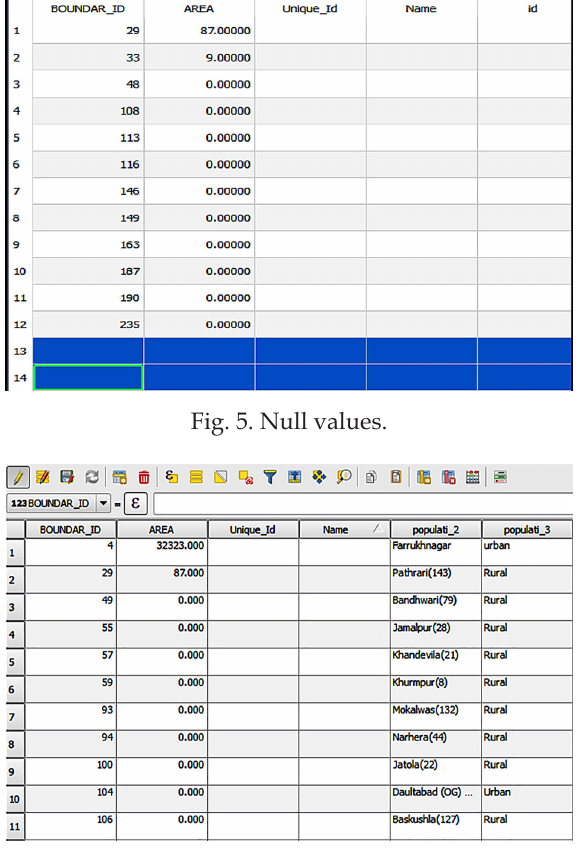
Fig. 6. Extraneous attributes.